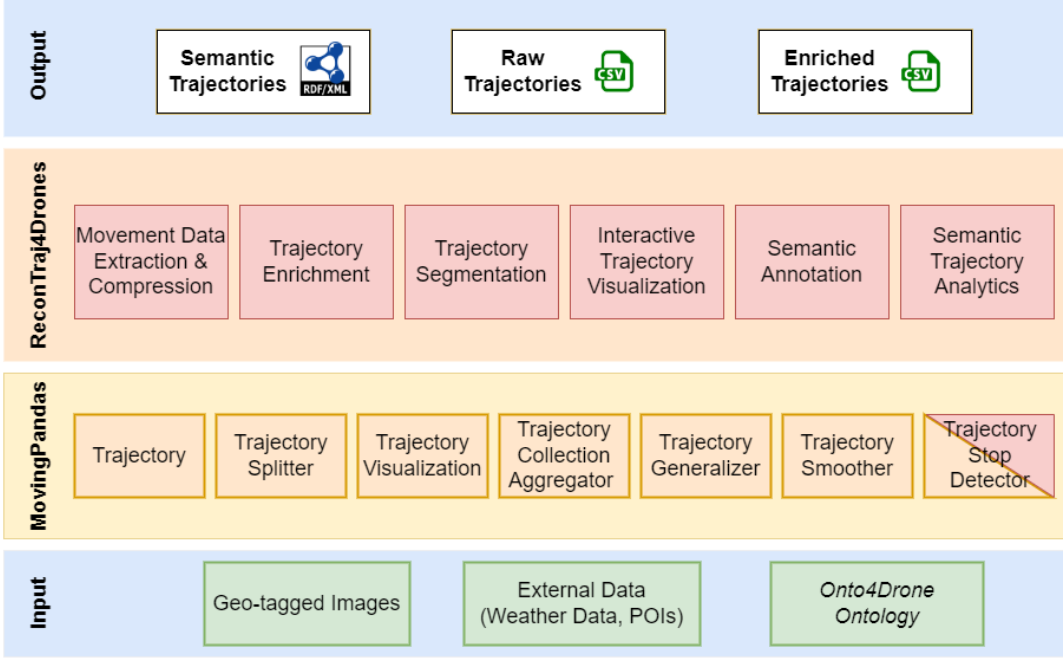
Figure 3. High-level architectural design of ReconTraj4Drones framework.